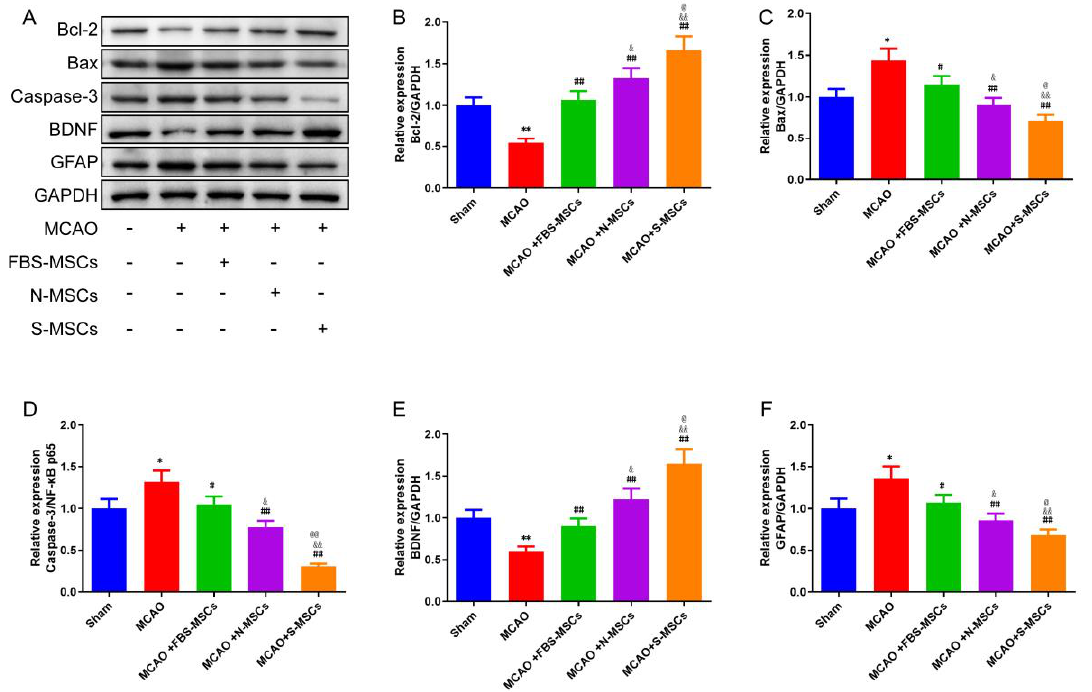
Figure 8. ( A ) Western blot analysis of the rat hippocampus neurons ( B ) Bcl-2, ( C ) Bax, ( D ) Caspase-3, ( E ) BDNF, and ( F ) GFAP proteins expression ( x ± s, n = 3). Compared with the sham group, * p <